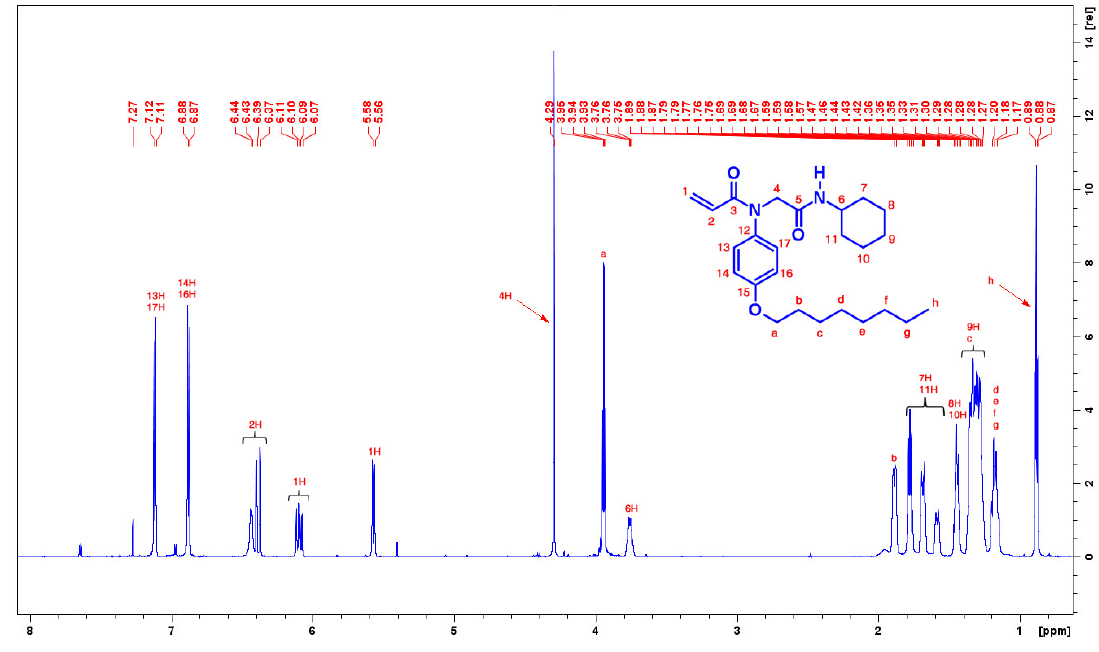
Figure 1. 1 H ‐ NMR spectra of desired compound (700 MHz, CDCl 3 ) at room temperature.